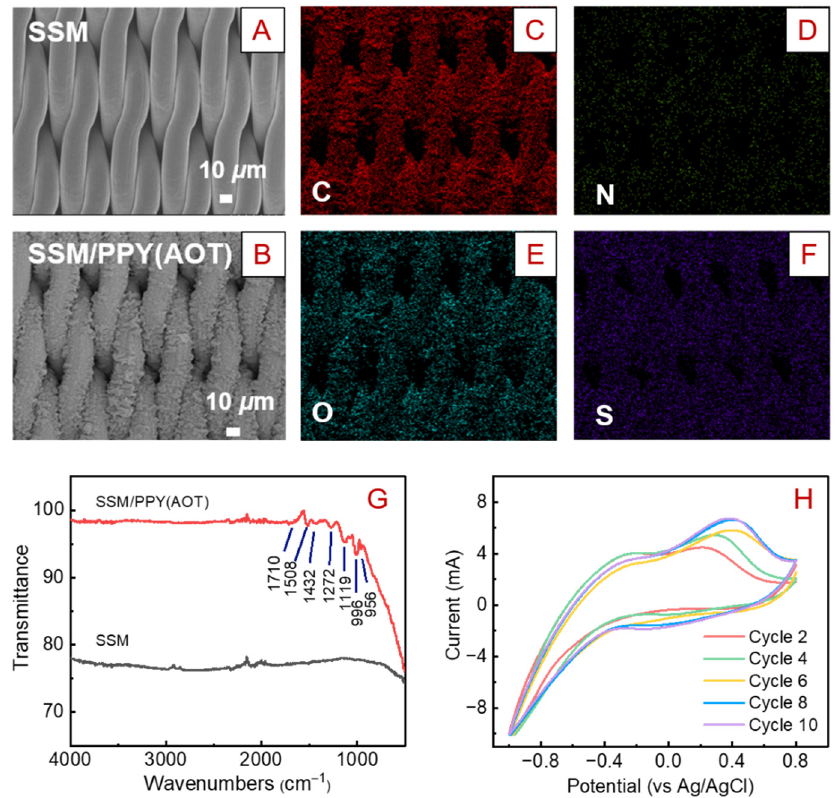
Figure 2. Characterizations of the SSM and SSM/PPY(AOT) membranes. SEM images of the ( A ) SSM and ( B ) SSM/PPY(AOT) membranes. Elemental mappings of the SSM/PPY(AOT) membrane: ( C ) C, ( D ) N, ( E ) O, and ( F ) S. ( G ) FTIR spectra of the SSM and SSM/PPY(AOT) membrane. ( H ) Cyclic voltammetry curves for the SSM/PPY(AOT)